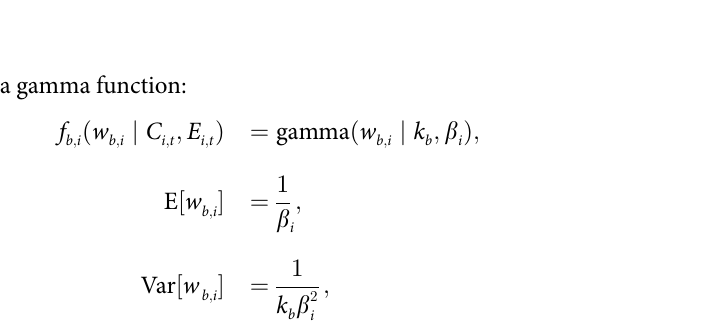
Fig 2. Definitions of neighborhood, or adjacent sites, in 2D (A) and 3D space (B). The focal site ( i th cell) is shown in blue, and its adjacent sites are in black. Note that there are not multipledefinitionsof neighborhoodin a hexagonal lattice.